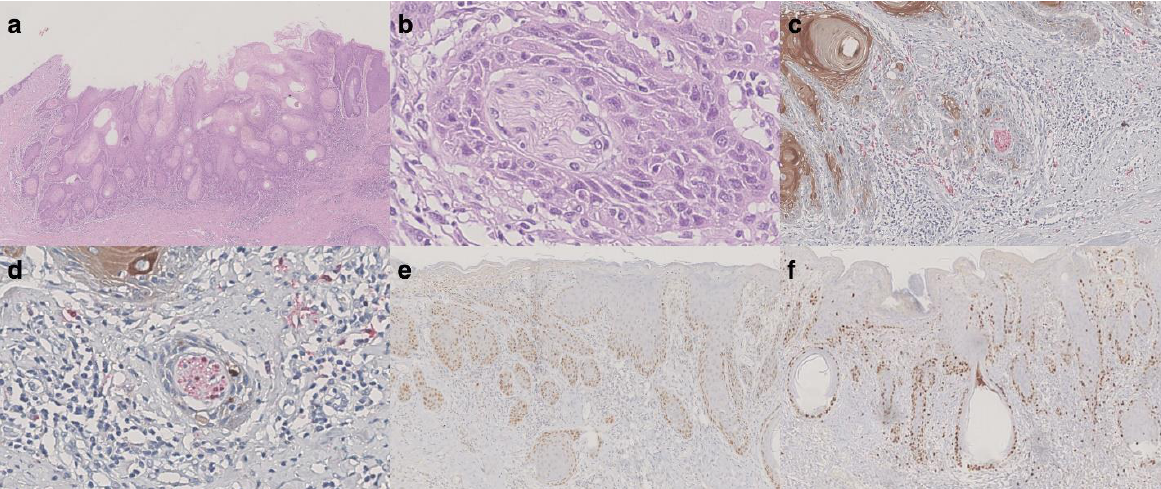
Figure 1. Histological features of vulvar recurrence with groin metastasis. ( a ) Hematoxylin and eosin (H&E) slide showing an invasive squamous cell carcinoma consistent with vulvar superficially invasive cancer (original magnification: 20×). ( b ) Perineural tumor invasion was observed, while no lymphovascular invasion was noted (original magnification: 400×). ( c , d ) Double immunohistochemical staining for S100 (red) and cytokeratins (AE1/AE3) (brown) confirming perineural invasion (original magnification for c: 200×, for d: 400×). ( e ) p53 showing widespread positivity (original magnification: 40 × ). ( f